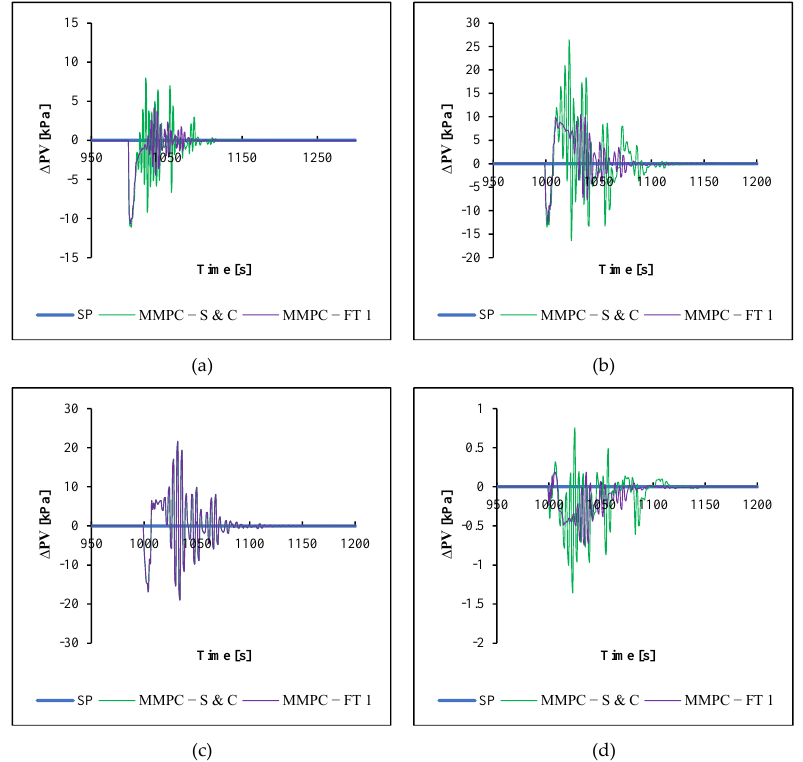
Figure 13. Controller performance on: ( a ) compressor unit 1; ( b ) compressor unit 2; ( c ) compressor unit 3; and ( d ) compressor unit 4 (Disturbance Test).